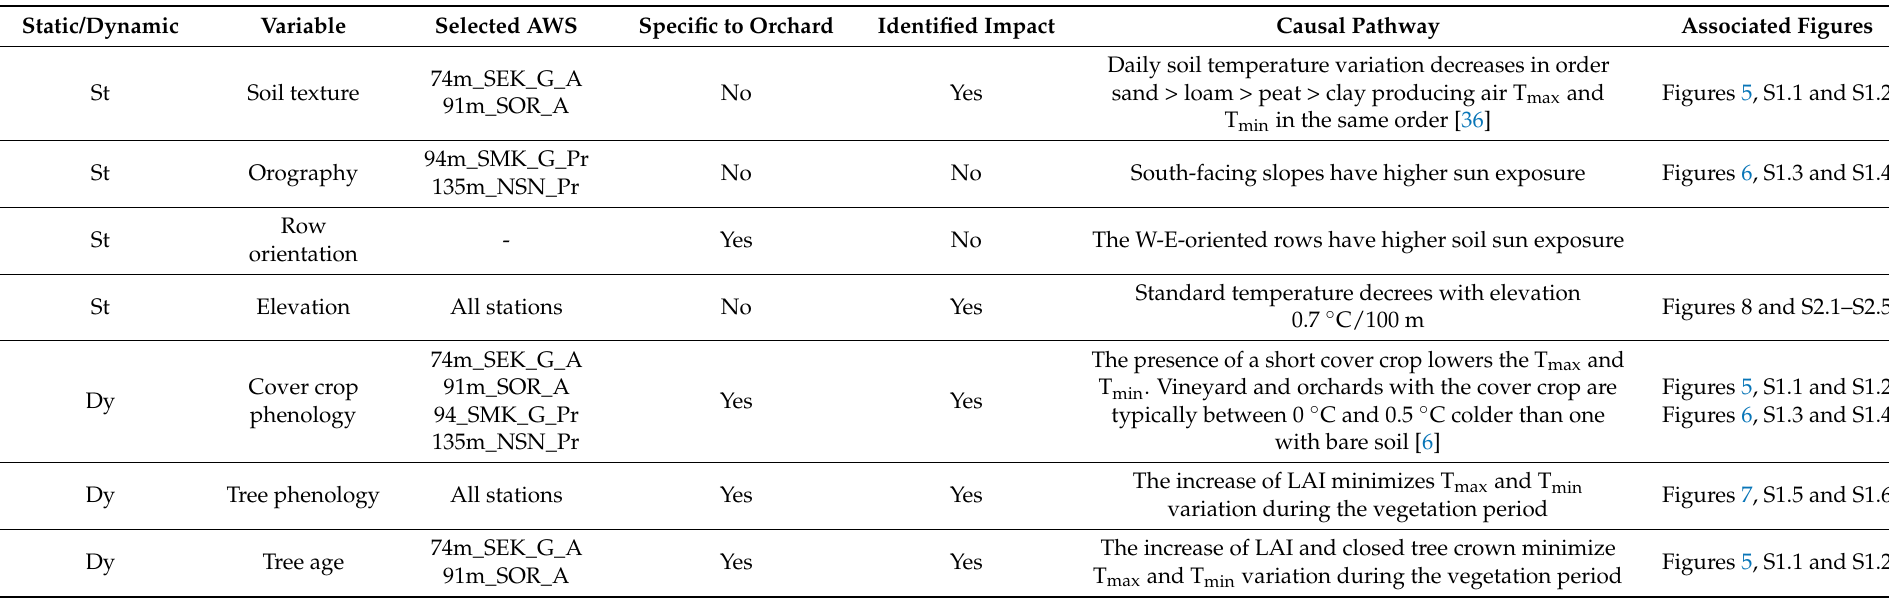
Table 3. List of static and dynamic variables with the expected casual